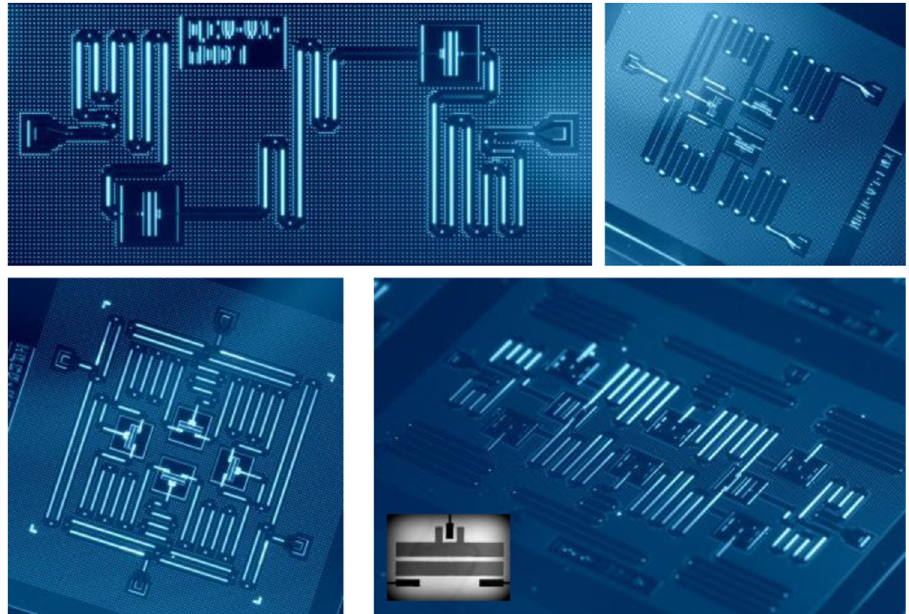
Fig. 4 Images of four recent devices fabricated at IBM. The device in the top left corner contains 2Q(qubits)/1B(us)/2R(eadout resonators) and is currently being used to study optimal two-qubit gates. The top right corner shows a device with 3Q/2B/3R which was used to demonstrate a parity measurement. 40 In the lower left corner is a device with 4Q/4B/4R for demonstrating the [[2,0,2]] code 17 and the lower right corner shows a device of 8Q/4B/8R for studying both Z and X parity checks. Inset shows an optical micrograph of an individual transmon